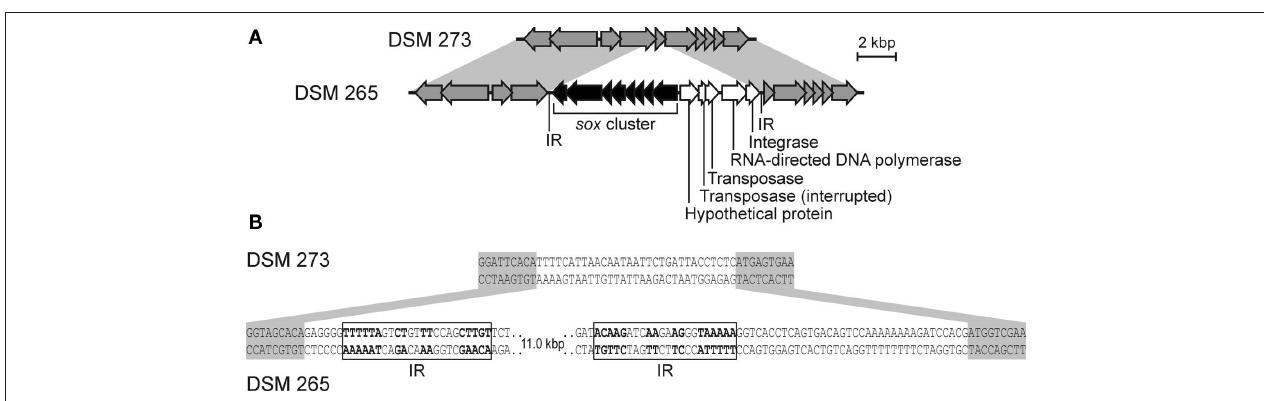
Figure 6 | The sox gene island in Chl. phaeovibrioides DSM 265. (A) Alignment of syntenic regions in Chl. luteolum DSM 273 and Chl. phaeovibrioides DSM 265. (B) Details of the sox gene island terminal sequences and insertion site. Genes marked in gray are not related to sulfur metabolism. Shades of gray indicate sequence similarity. IR, inverted